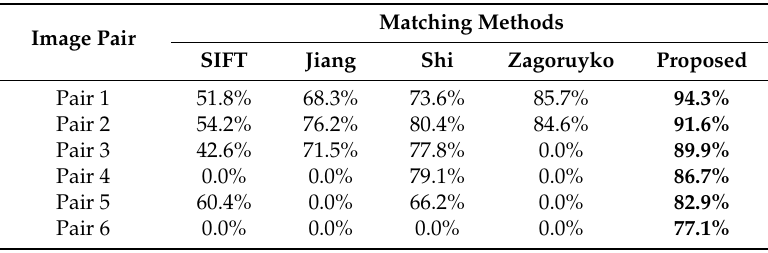
Table 3. MP values of each method for remote sensing images with complex background variations.